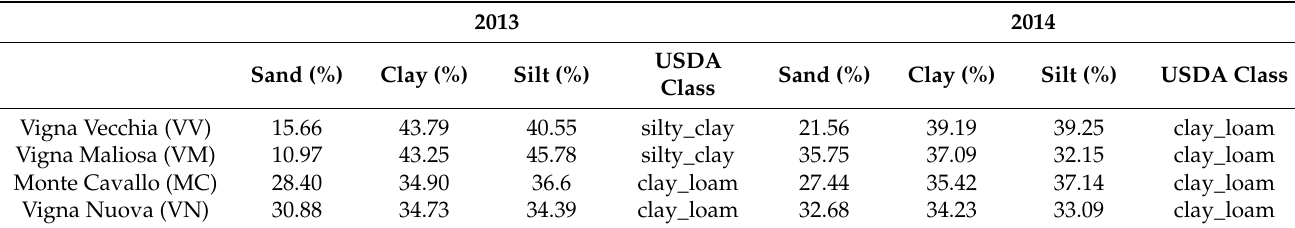
Table 1. Soil textural classification by individual size-groups (%) of mineral